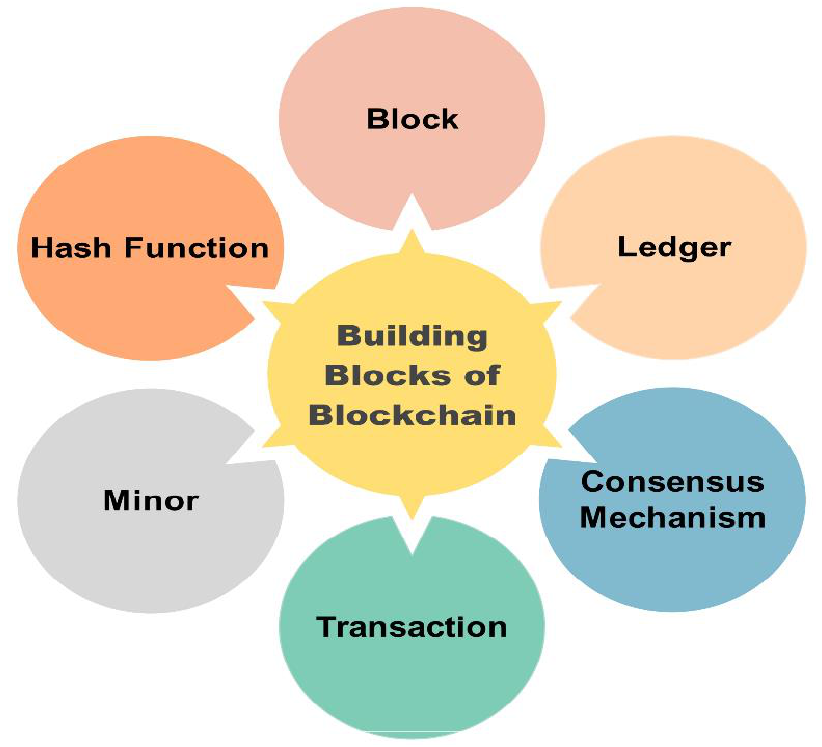
Figure 4. Main components of blockchain.